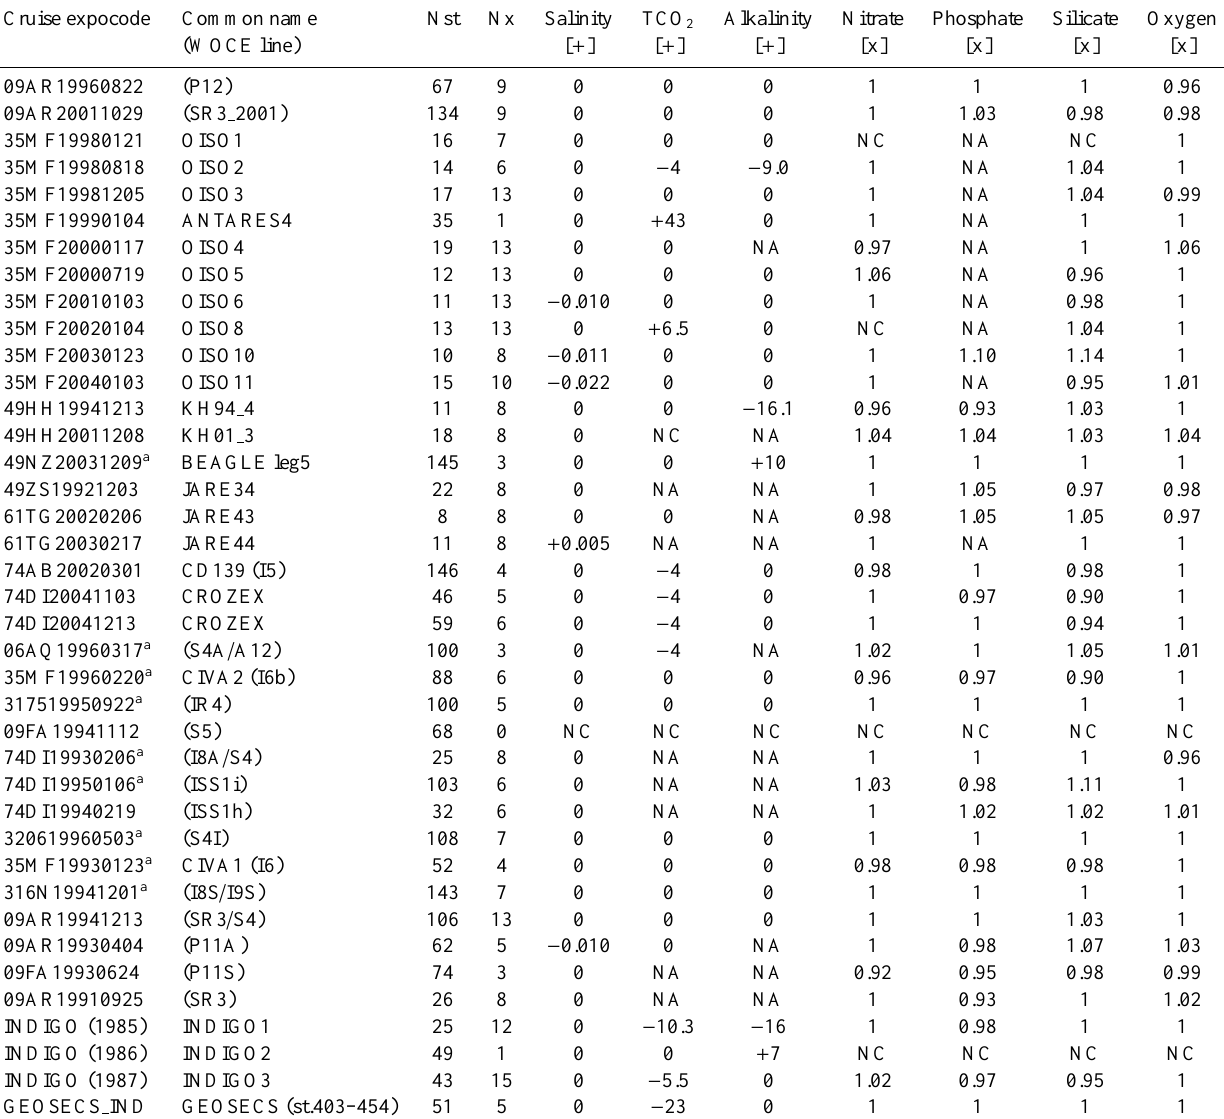
Table 2. Number of stations (Nst), number of crossovers (Nx) and final adjustments applied to the CARINA data product and recommended for GLODAP